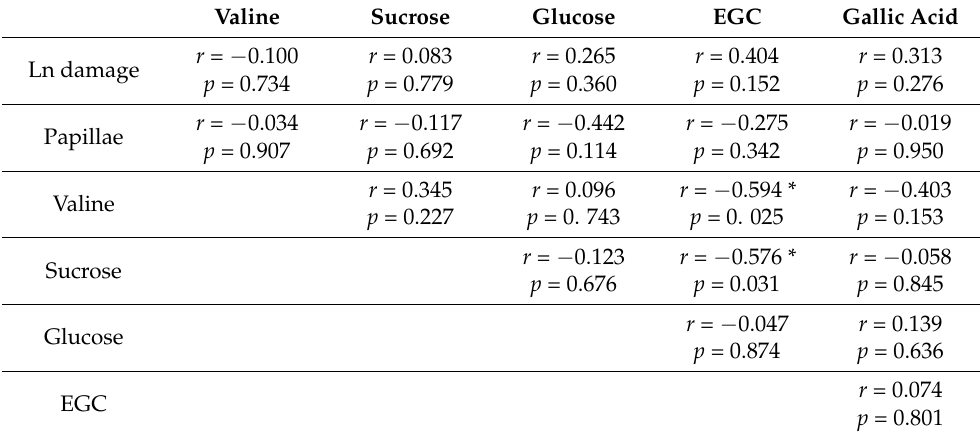
Table 2. Correlations between the concentrations of metabolites that are not related to thrips resistance and silver damage and the density of papillae in 14 Gladiolus varieties. Silver damage was ln- transformed to obtain normally distributed data. * = p < 0.05 and N = 14 in all cases. Spearman correlations were used for the relationships between silver damage, epigallocatechin (EGC), gallic acid, and density of